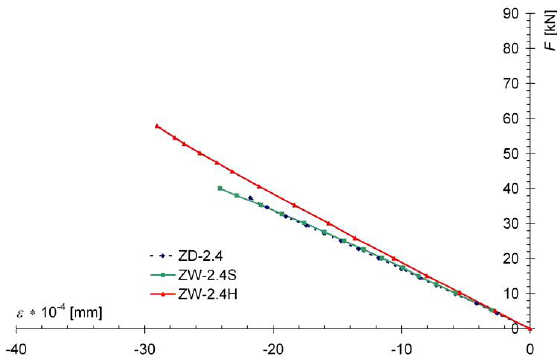
Figure 12. Graph of F- ε dependence in compressed marginal wood fibers in the center of the model span, showing average values.